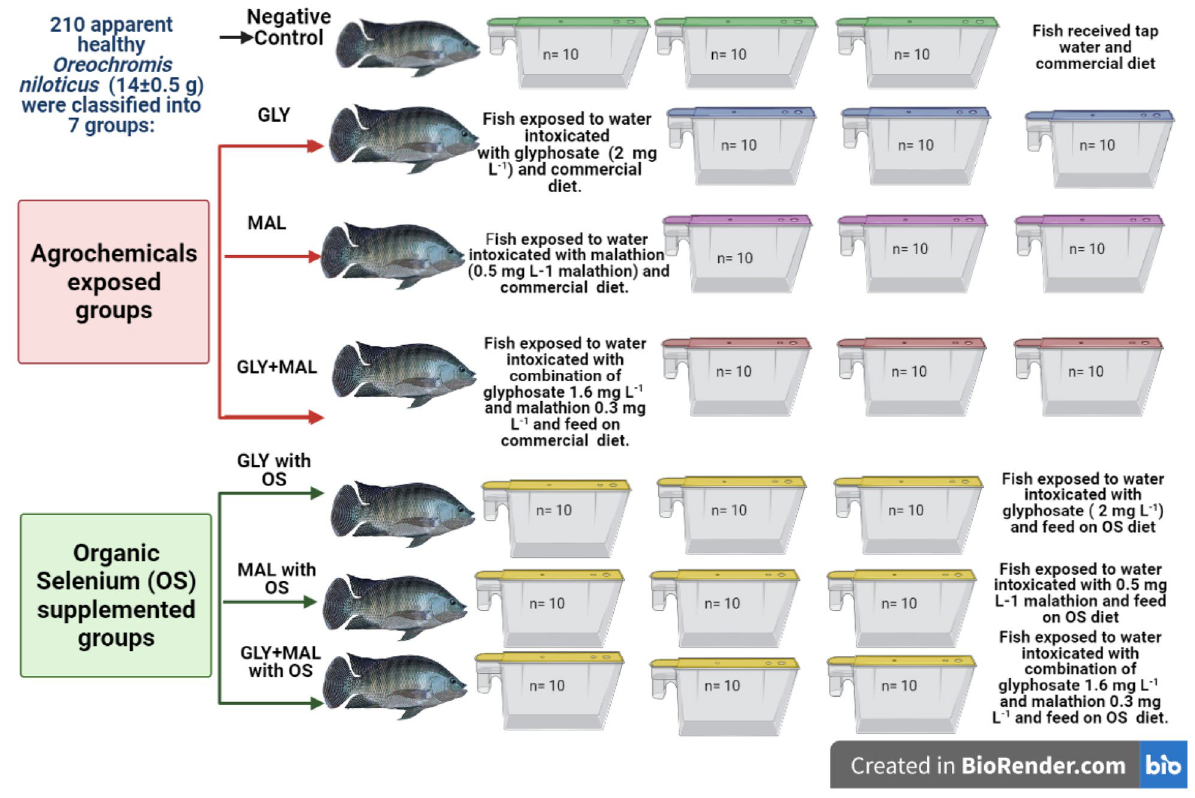
Figure 1. Experimental groups design